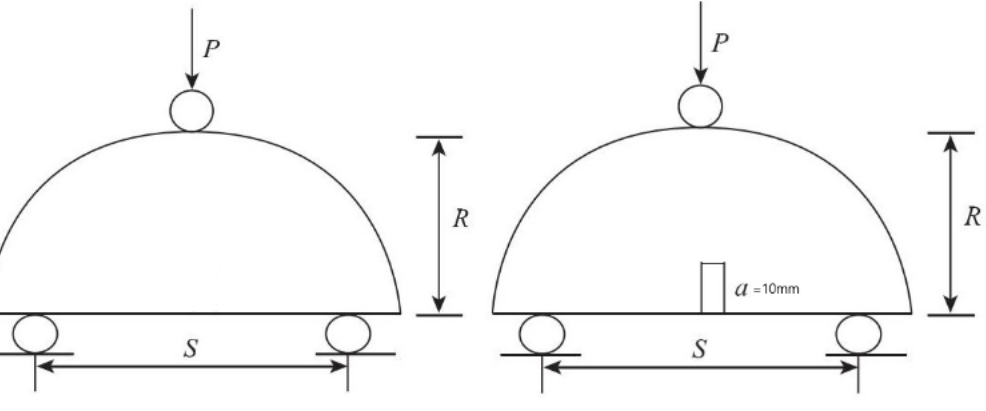
Figure 1. Schematic diagram of semicircular specimen.